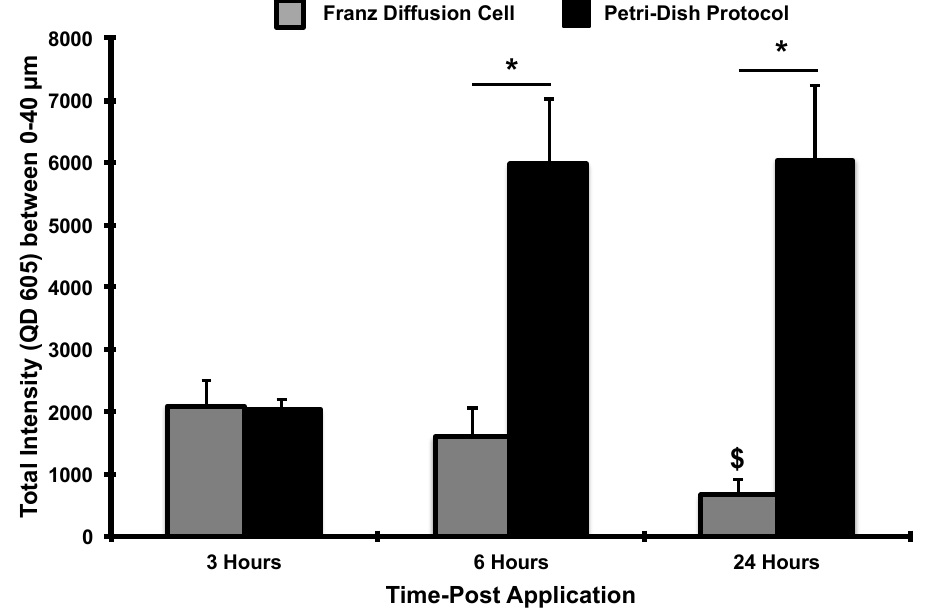
Figure 5. QD penetration trends between ex vivo mouse and rested human skin following a 24 h exposure using the petri dish protocol are comparable. No significant differences in the integrated QD fluorescence intensity were observed in the Eucerin smoothing lotion and water test groups between mouse skin and human skin rested for 24 h post-processing. A ~3-fold higher QD presence was observed in the Dermovan group was detected in mouse skin relative to rested human skin; mean ± SEM ( N = 4, n = 3). * p < 0.05.